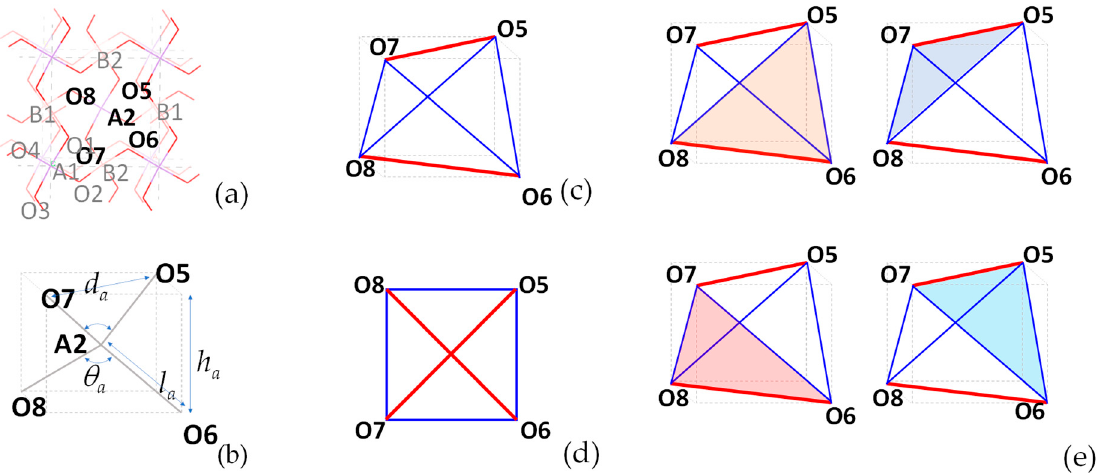
Figure 2. ( a ) The unit cell of BAsO 4 with the atoms labelled, ( b ) an illustration of how this tetrahedron, which is in the shape of a tetragonal disphenoid, is representable as atoms and bonds, and how it fits within a cuboid with a square upper and lower face; ( c ) a representation of this tetrahedron in terms of the edges where the two equal Set 1 edges are shown in red and the four equal Set 2 edges are shown in blue, ( d ) the 2D projection of this tetrahedron, looking from above, to highlight the 2D projection of a square (which in BAsO 4 corresponds to the (001) plane); and ( e ) a highlight of the four congruent triangular faces of the